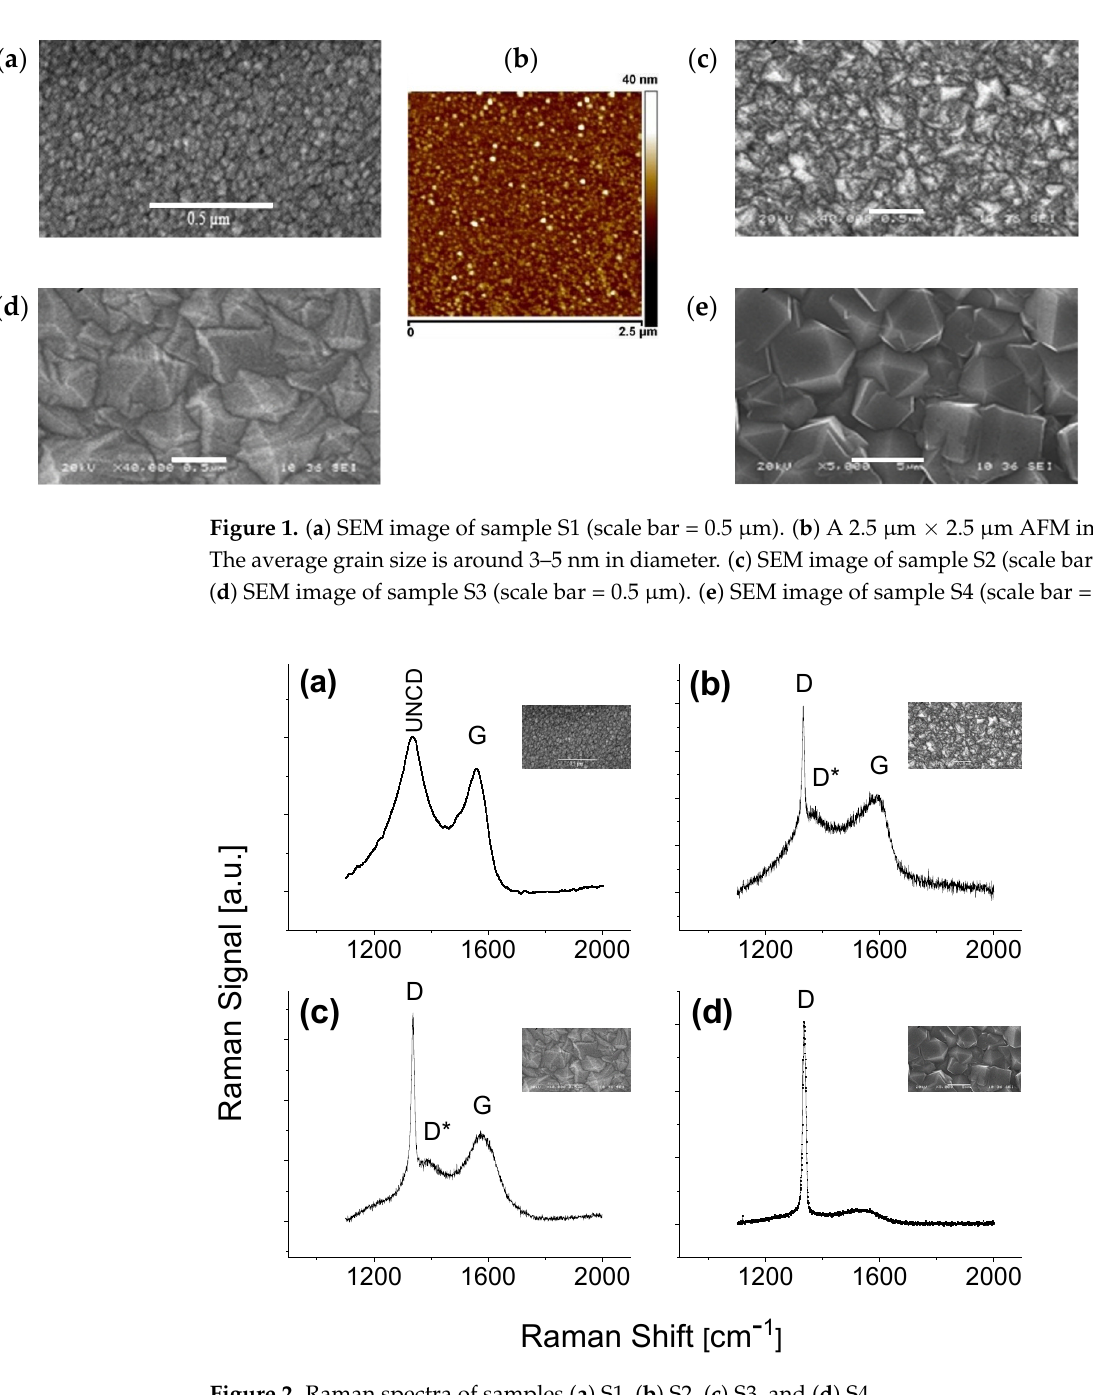
Figure 2. Raman spectra of samples ( a ) S1, ( b ) S2, ( c ) S3, and ( d ) S4.